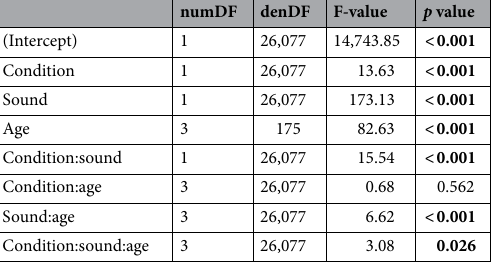
Table 1. F-tests for main effects and interactions in the condition effect model. Statistically significant results are marked in